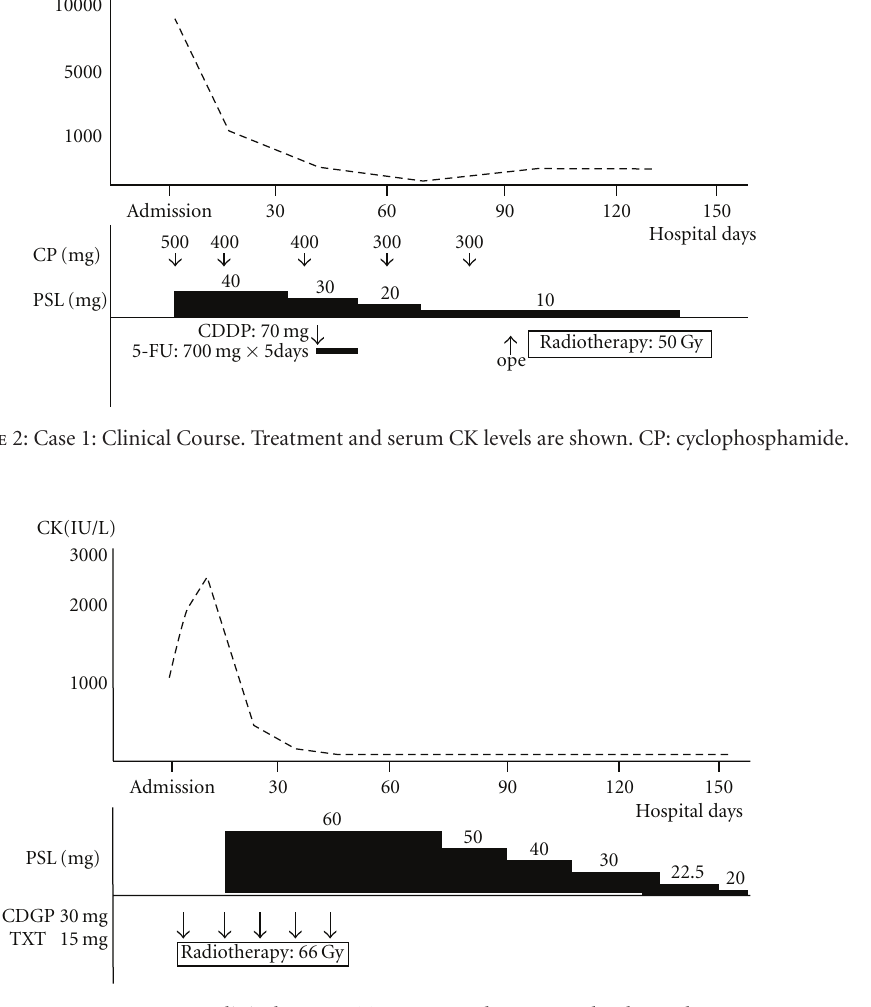
Figure 3: Case 2: Clinical Course. Treatment and serum CK levels are